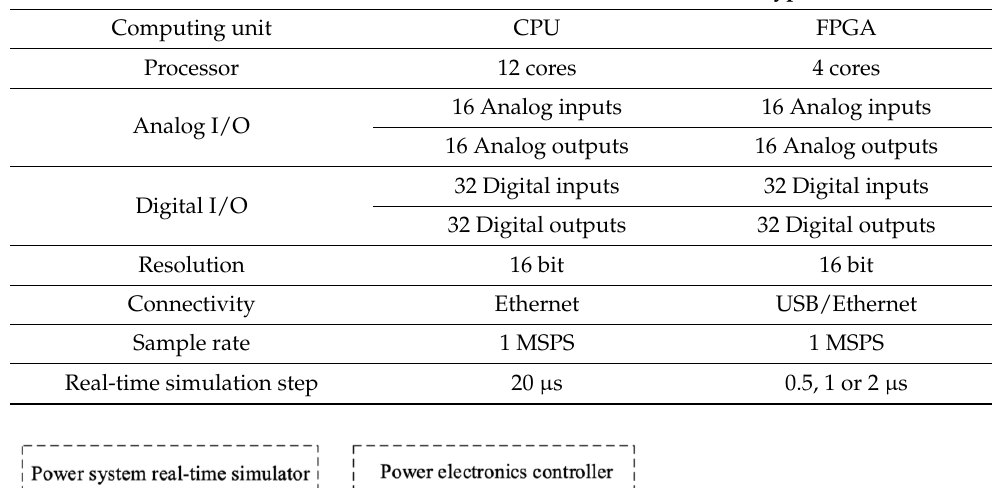
Table 2. Performance Parameters of Real-Time Simulator.